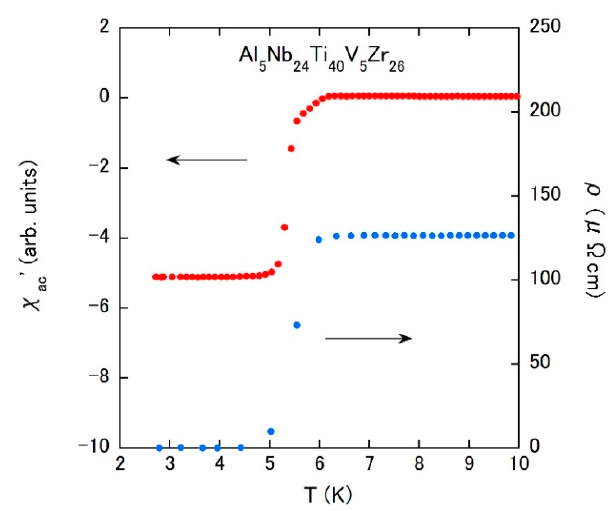
Figure 12. Temperature dependences of the ac magnetization and electrical resistivity of Al 5 Nb 24 Ti 40 V 5 Zr 26 .